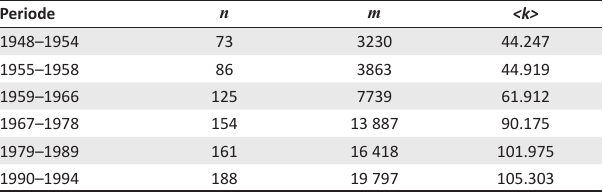
TABEL 2: Makrovlakstatistieke van die wêreldhandelnetwerk vir die 6 periodes wat hier ondersoek